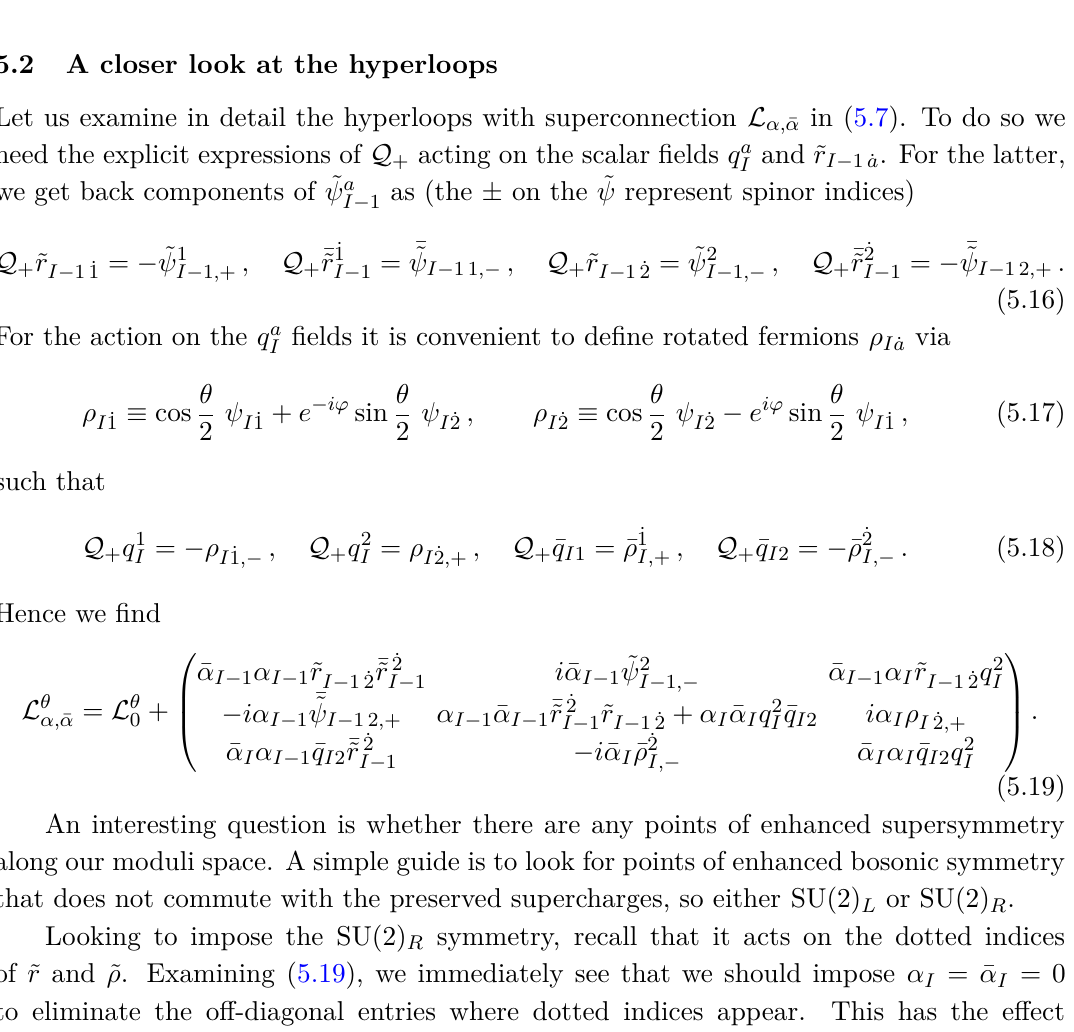
Figure 7 . The other class of 1 / 16 BPS